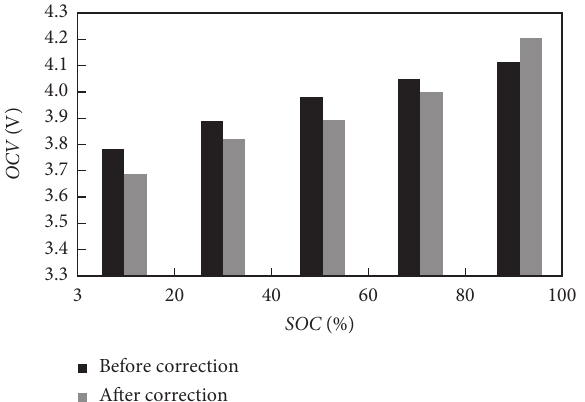
Figure 4: Comparison of the OCV-SOC curve of the lithium manganate battery before and after modification.